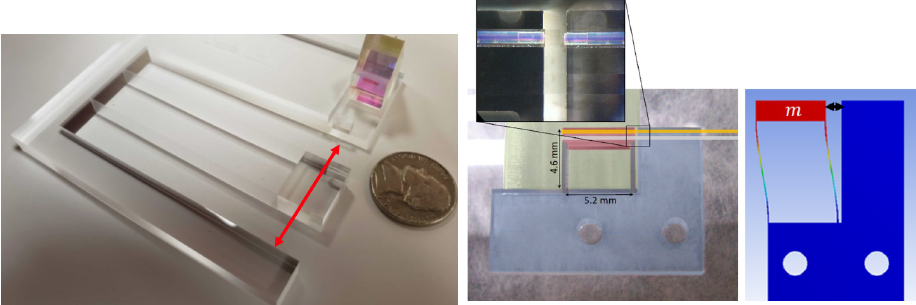
Figure 1. Left: low-frequency (LF) opto-mechanical resonator [23]. Red arrow indicates the sensitive axis. Right: High-frequency (HF) opto-mechanical resonator [19].